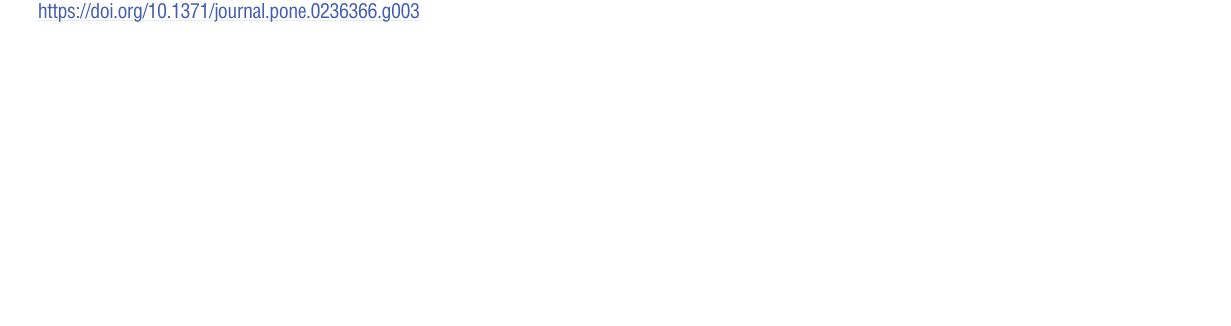
PLOS ONE | https://doi.org/10.1371/journal.pone.0236366 July 23,